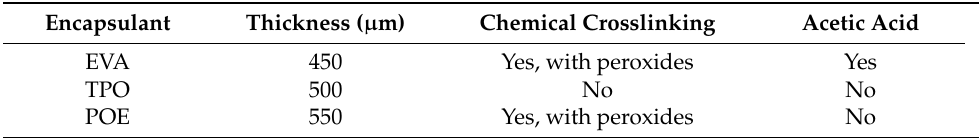
Table 1. Encapsulants characteristics.